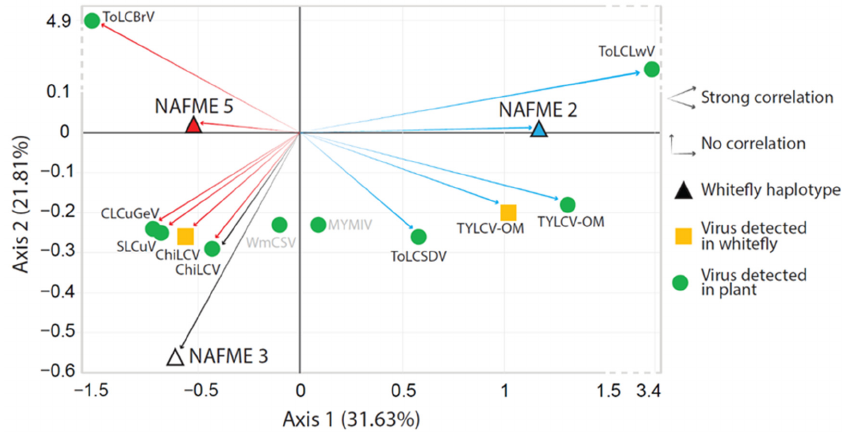
Figure 4. Correspondence analyses between whitefly haplotypes NAFME 2, 3, and 5 and begomovirus species detected in whitefly and plant samples. Red arrows show positive associations between begomovirus species and whitefly haplotype NAFME 5; blue arrow indicates positive associations between begomovirus species and NAFME 2 haplotype. Black arrow shows the association between the single begomovirus species detected in symptomatic plants infested by the NAFME 3 haplotype.